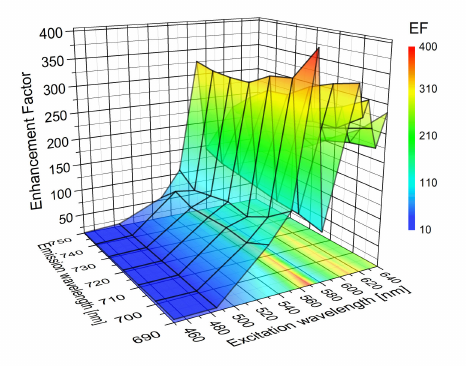
Figure 10. Three-dimensional representation of EFs of emission intensities of Thermosynechococcus elongatus PSI complex as a function of excitation and emission wavelengths.